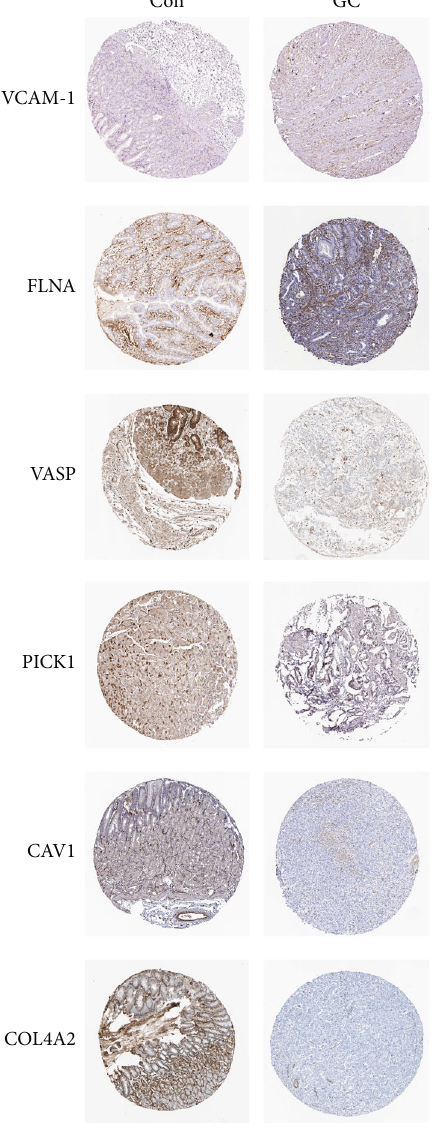
Figure 6: Theproteinlevelsof VCAM1,FLNA,VASP,CAV1,PICK1, and COL4A2 in GC and adjacent normal tissue. Images were obtained from the Human Protein Atlas